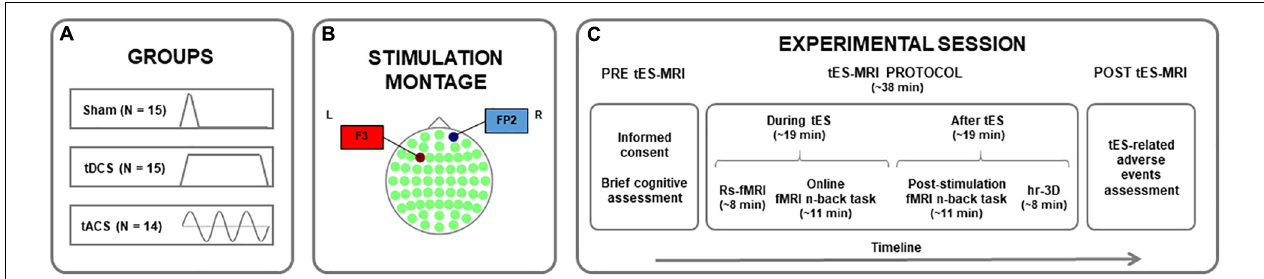
FIGURE 1 | Study protocol. (A) Assignment of participants to one of the experimental groups. (B) Stimulation montage for all groups, with the first electrode (anode for tDCS) centered over the F3 (in red) and the second electrode (cathode for tDCS) placed over the FP2 (in blue) in a 10–10 system map. (C) Timeline of the procedures accomplished before, during and after the tES-MRI protocol. tDCS, transcranial direct current stimulation; tACS, transcranial alternating current stimulation; tES, transcranial electrical stimulation; MRI, magnetic resonance imaging; rs-fMRI, resting-state functional MRI; hr-3D, high-resolution three-dimensional.